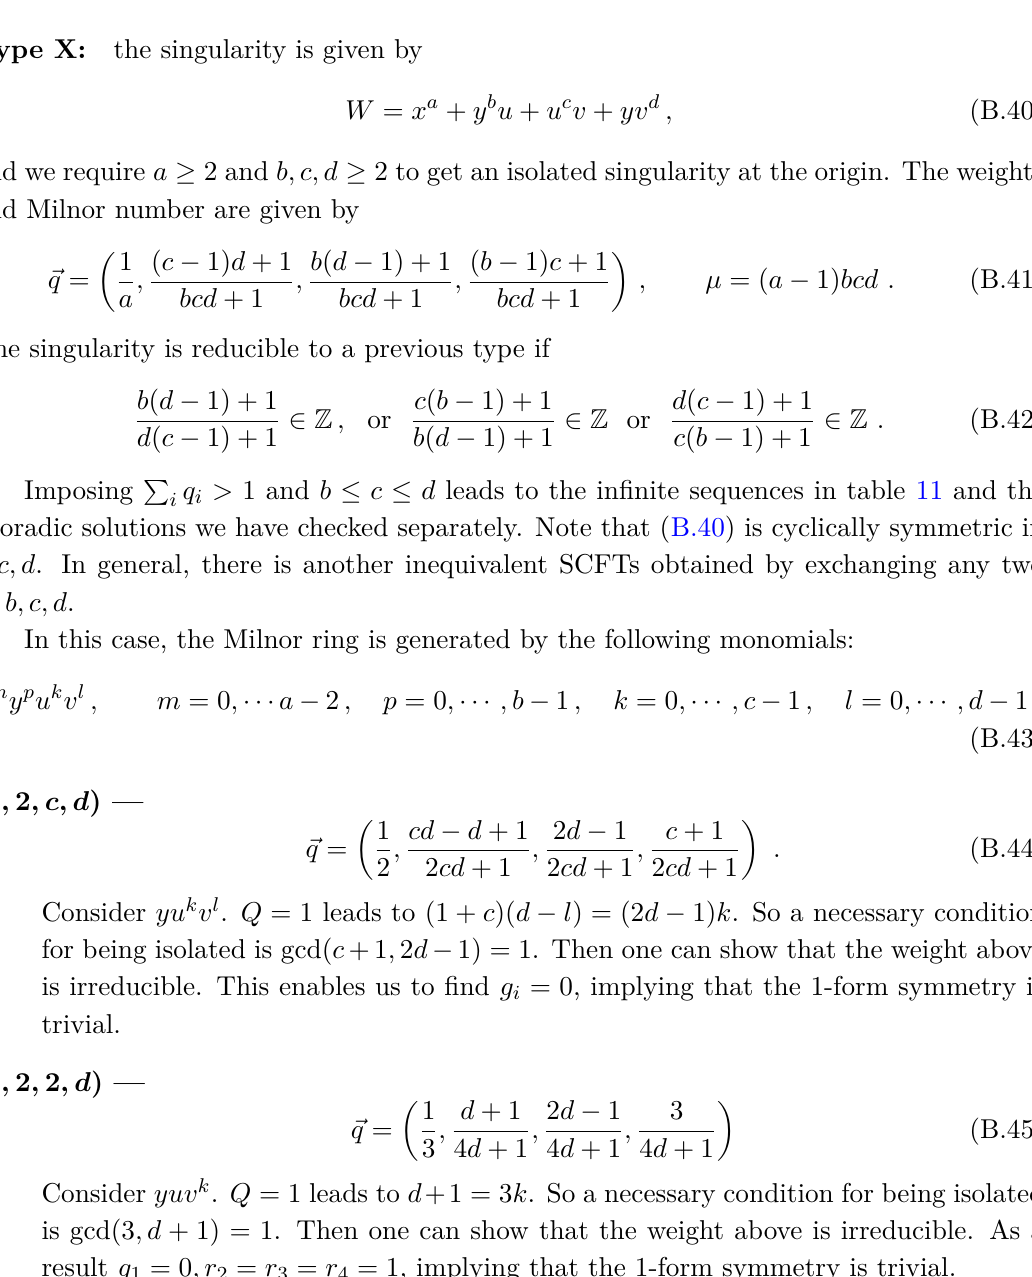
Table 11 . Infinite sequences of type X singularities. The table is invariant under exchanging two of b, c, d . Gray entries are reducible to previous types of singularities. This table is adapted from [28].